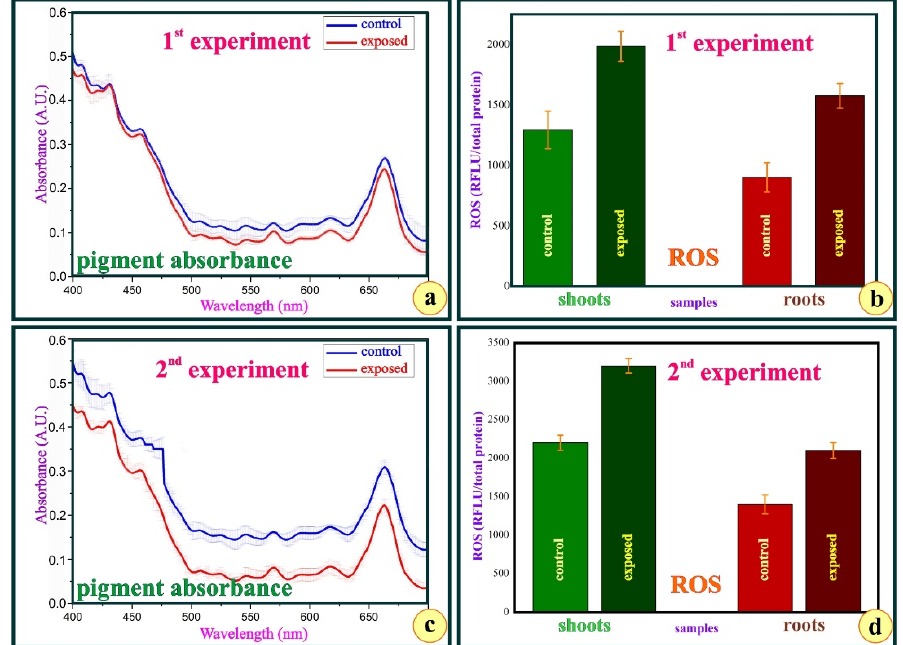
Figure 4. ( a ) The absorption spectrum of the photosynthetic pigments after the first experiment. ( b ) Bar graphs depicting measured reactive oxygen species (ROS) levels after the first experiment. ( c ) The absorption spectrum of the photosynthetic pigments after the second experiment. ( d ) Bar graphs depicting measured ROS levels after the second experiment. Differences were considered as statistically significant when p < 0.05 (*). Error bars represent the standard error of the mean (SEM, N = 4, n = 2).